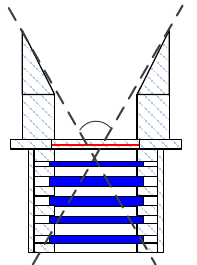
Figure 11. Schematic diagram of detection opening angle structure in the high-energy particle detector. The detection opening angle of each high-energy proton probe is 40 ◦ , and the geometric factor is about 0.30 cm 2 sr. According to this geometric factor, the counting of each energy range can be evaluated, as shown in Table